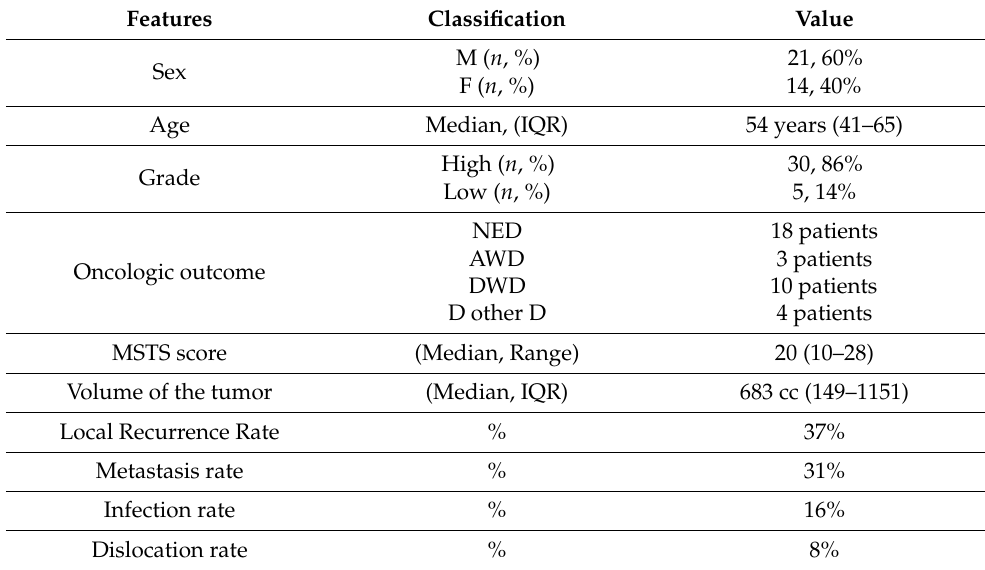
Table 1. Demographic, oncological and complications data of the population.